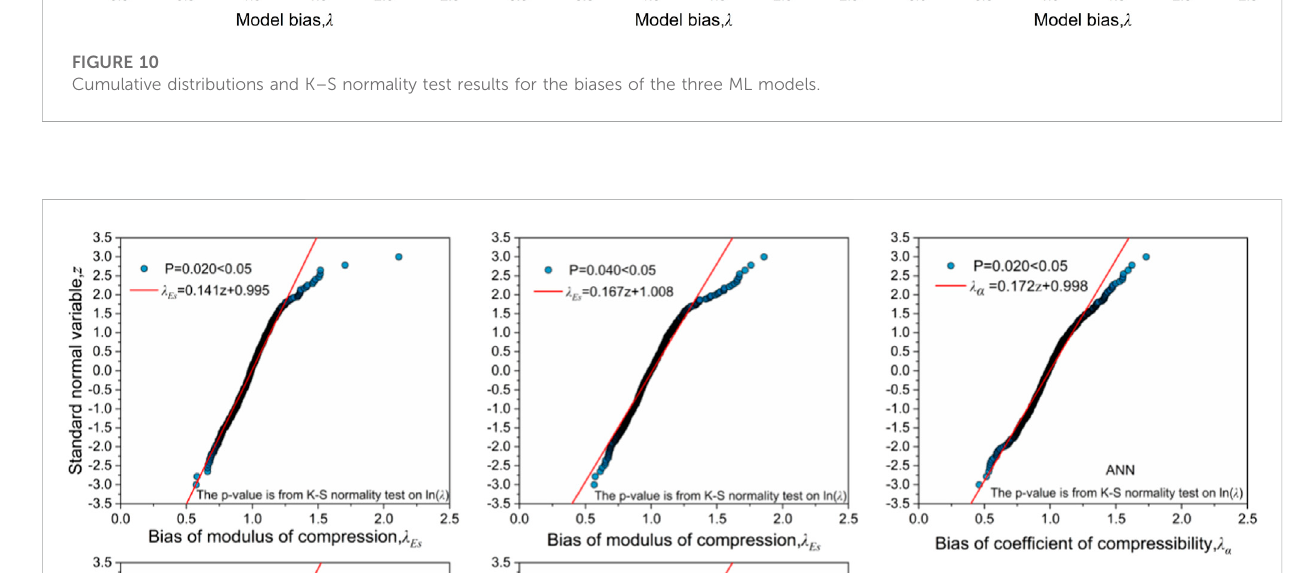
Optimization of model parameters for this type of model mainly